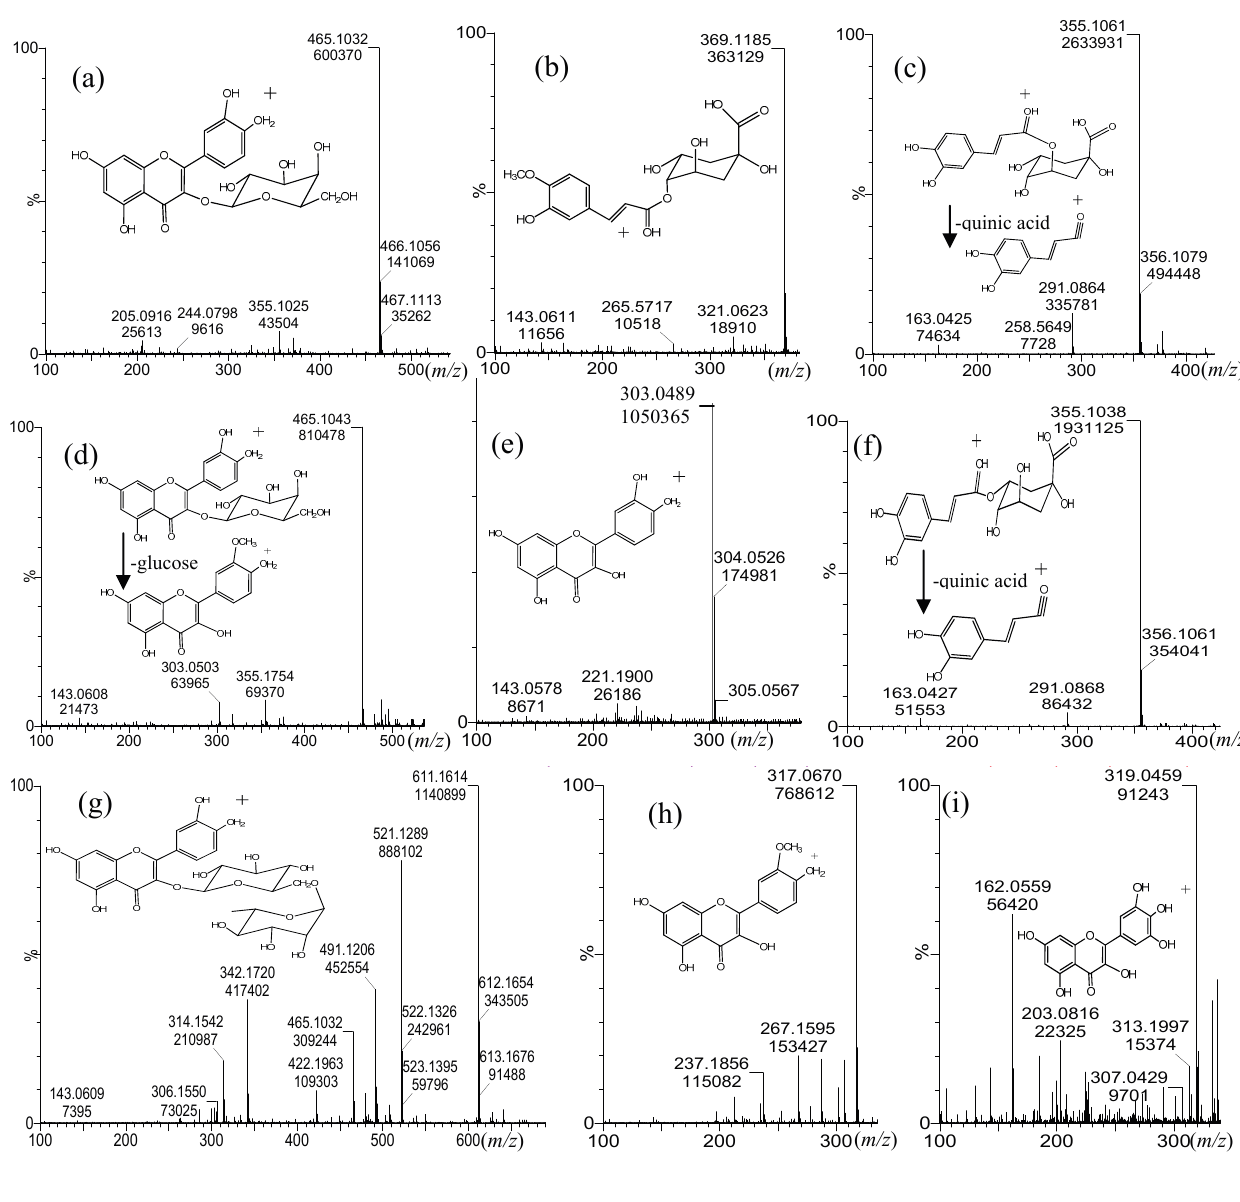
Figure 4. Full scan ToF MS spectra and structures of minor phenolic compounds detected in six berries from the VIII region of Chile. ( a ) Hyperoside, ( b ) feruloyl-quinic acid, ( c ) chlorogenic acid ( d ) isoquercitrin ( e ) quercetin, ( f ) neochlorogenic acid ( g ) rutin ( h ) isorhamnetin and ( i )